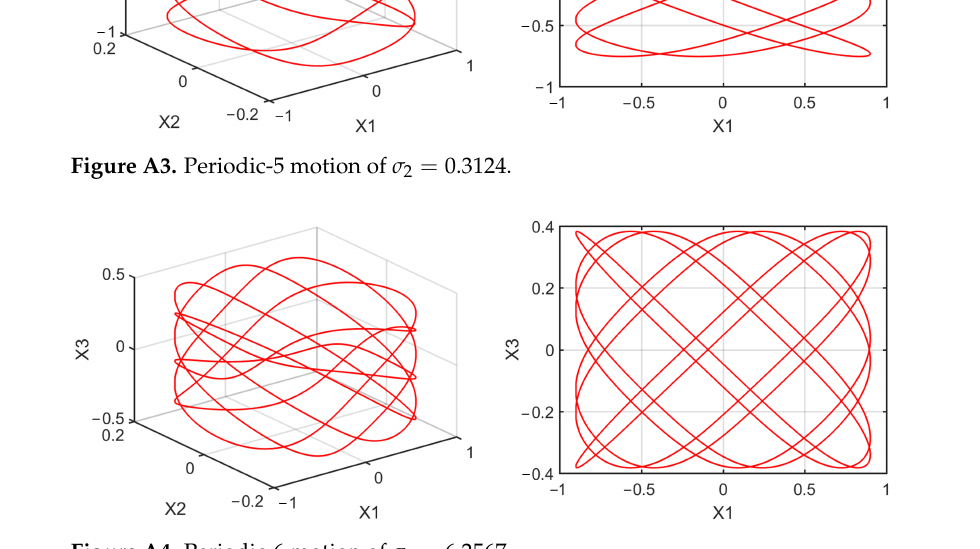
Figure A4. Periodic-6 motion of σ 2 = 6.2567.